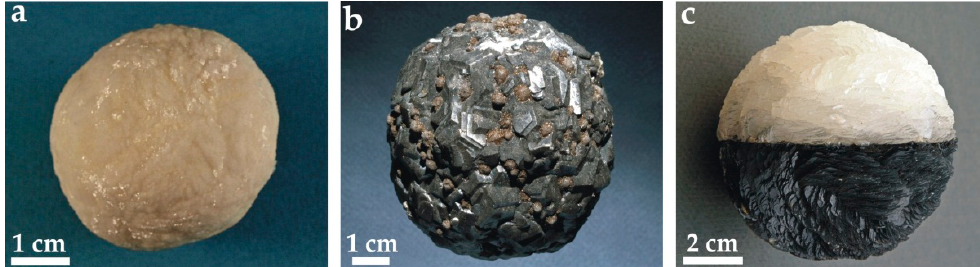
Figure 1. Epithermal calcite spheres from the Herja ore deposit hosted by County Museum of Mineralogy „Victor Gorduza”, Baia Mare; ( a ) White dominated calcite sphere (4.5 × 4.5 × 5 cm) with a minor black calcite section (not visible), sample 177099; the sphere has apparently an inner void hosting solid inclusions as indicated by the noise that occurs when the sample is joggled; ( b ) Black calcite sphere (6 × 6 × 6 cm), formed of rhombohedra of up to 10 mm long edges; A3 axis of each rhombohedron seems to be parallel to the radius of the sphere; the black calcite is covered by small-sized siderite spheres and apparently marcasite “dust”; sample 12990; ( c ) Bicolor calcite sphere composed of uneven volumes of white and black calcite. The sample is classified as a Romanian national patrimony specimen and was hosted by the County Museum of Mineralogy „Victor Gorduza”, Baia Mare until January, 2014 when it was stolen; ( a ) and ( b ) photos by Ioan Bere ș , ( c ) photo by Valentin Gan ț a.